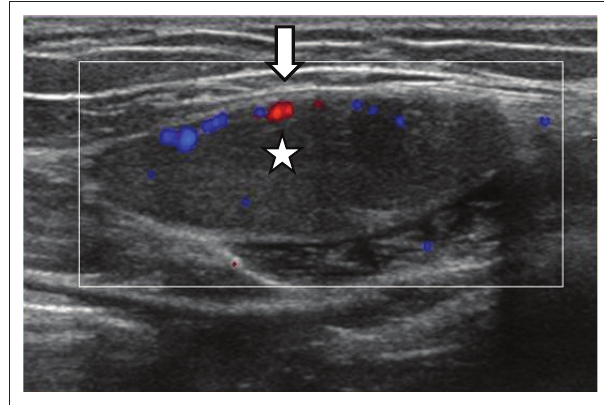
FIGURE 2: Greyscale ultrasound in a 6-month-old infant showing an undescended testis in the right inguinal canal